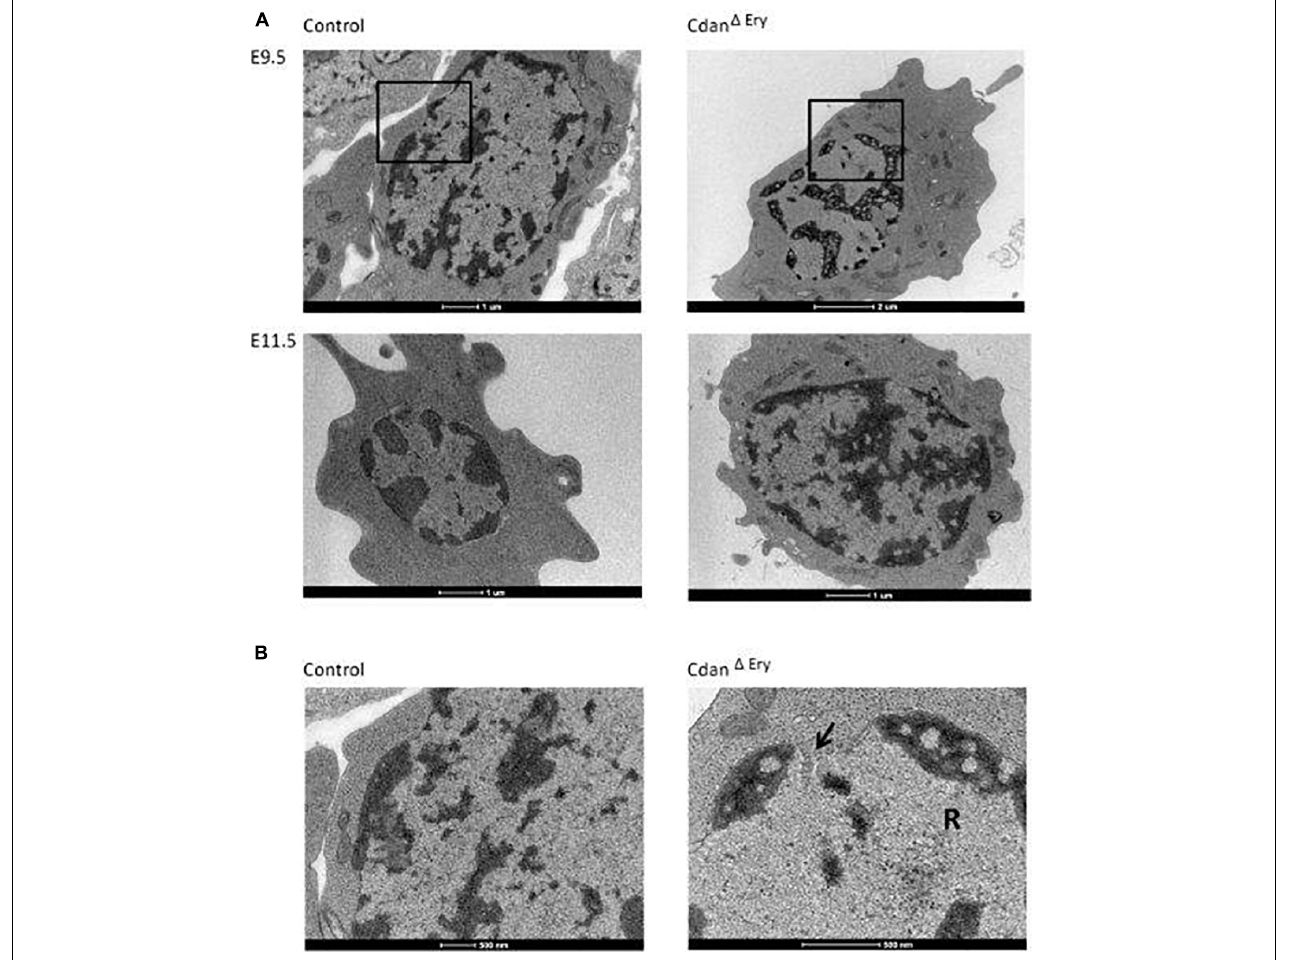
FIGURE 3 | Cdan (cid:49) Ery erythroblasts display the pathognomonic spongy heterochromatin of CDA type I. (A) TEM of E9.5 (upper panel) and E11.5 (lower panel) Cdan (cid:49) Ery erythroblasts compared to littermate controls. Magnification: X6000-9900. Scale bar: 1–2 µ m. (B) High power magnification (X20,000-43,000) of E9.5 erythroblasts in A, showing the normal appearance of heterochromatin and the intact nuclear membrane in control erythroblast (left), compared to Cdan (cid:49) Ery erythroblast with spongy heterochromatin, dilated membrane pore (arrow) and ribosomes (R) inside the nucleus. Scale bar: 500